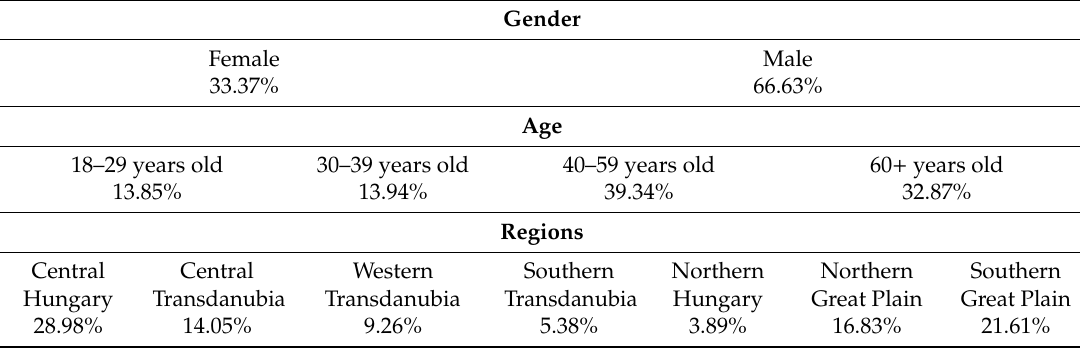
Table 1. Demographic data of the survey on extreme fish